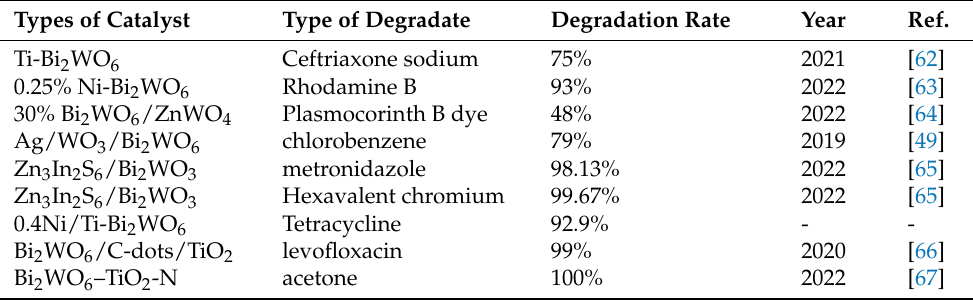
Table 1. The degradation efficiency of different photocatalytic materials.